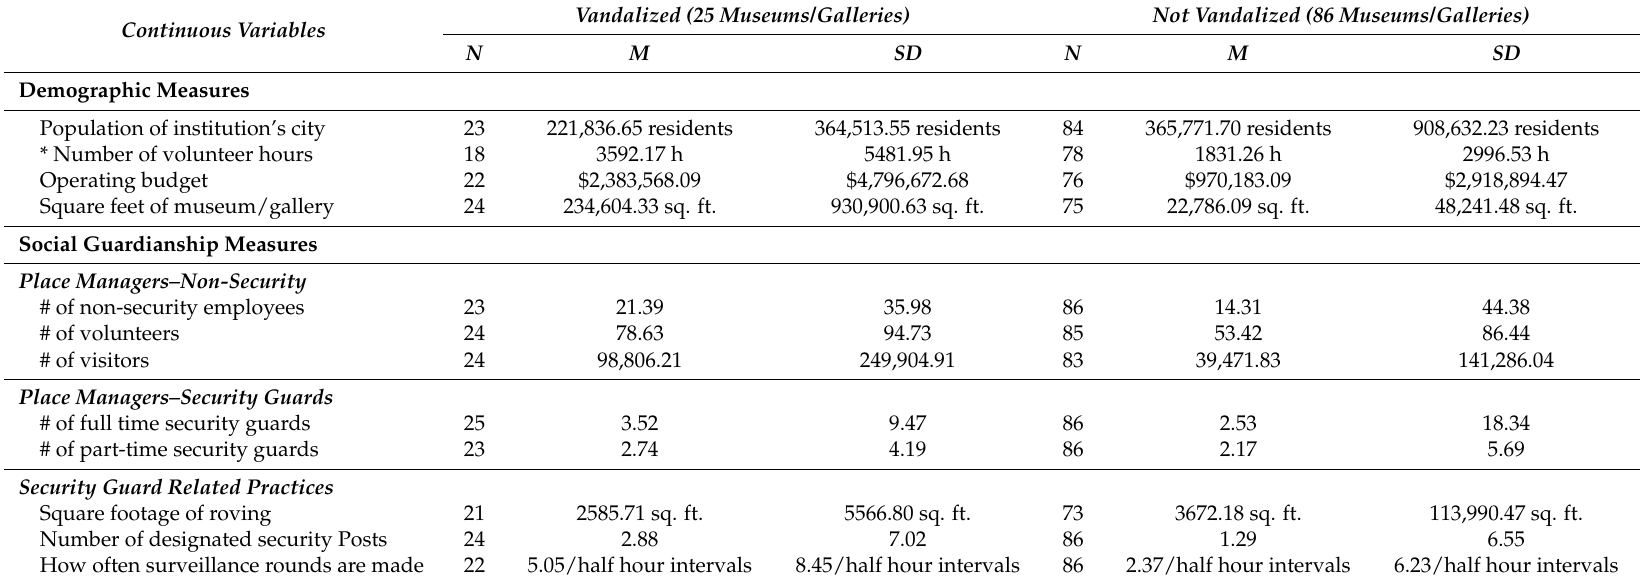
Table 1. Descriptive statistics of museums/galleries that were victimized by art vandalism compared with museums/galleries that were not victimized by art vandalism, continuous